Question: Name the type of graph shown.
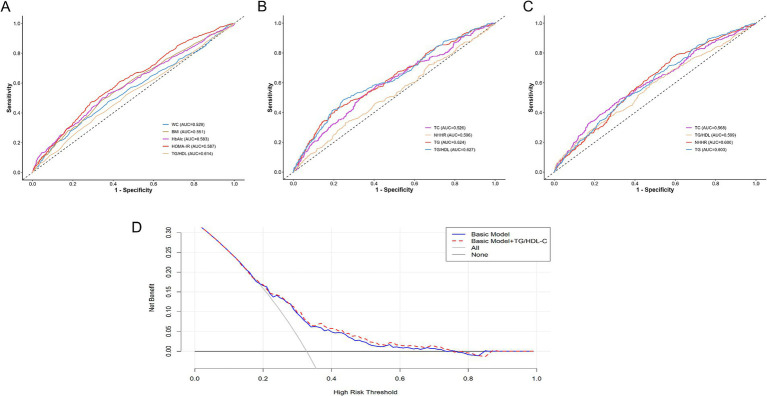
Answer: line